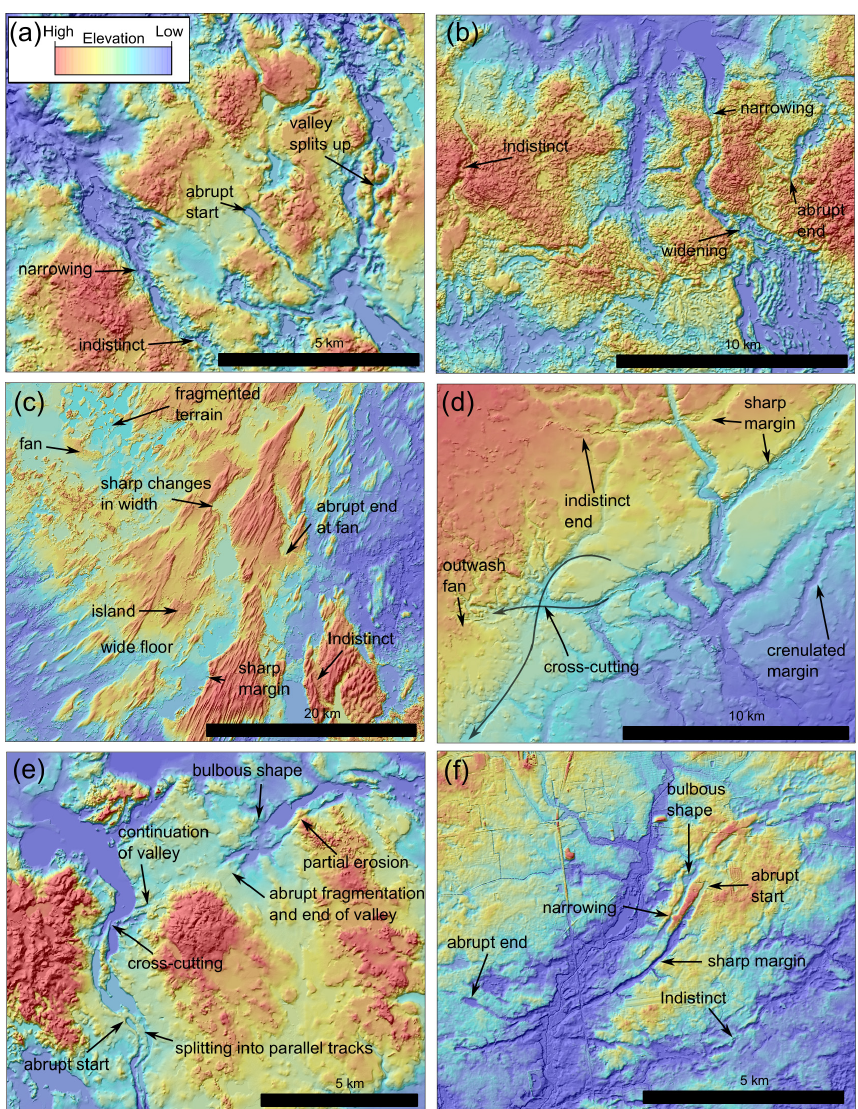
Figure 8. Examples of tunnel valley morphology of tunnel valleys with a confidence of 1 or 2. (a) Superior Lobe (note the amphitheatre heads of some valleys); (b) Wadena Lobe (note the large downstream changes in tunnel valley width); (c) Langlade Lobe; (d) Saginaw Lobe; and (e) Wadena (note the parallel valleys) and (f) Huron-Erie (note the abrupt start and end points of the tunnel valleys and parallel organisation). In (d) , there is an example of two cross cutting tunnel valleys that formed at different times during eastward ice retreat (see also Mooers, 1989). The valley trending E–W terminates at an outwash fan, which must mark the position of the ice margin when it was formed. The valley cross-cutting it can be traced several tens of kilometres further to the west and therefore must have formed during an earlier phase when ice was more